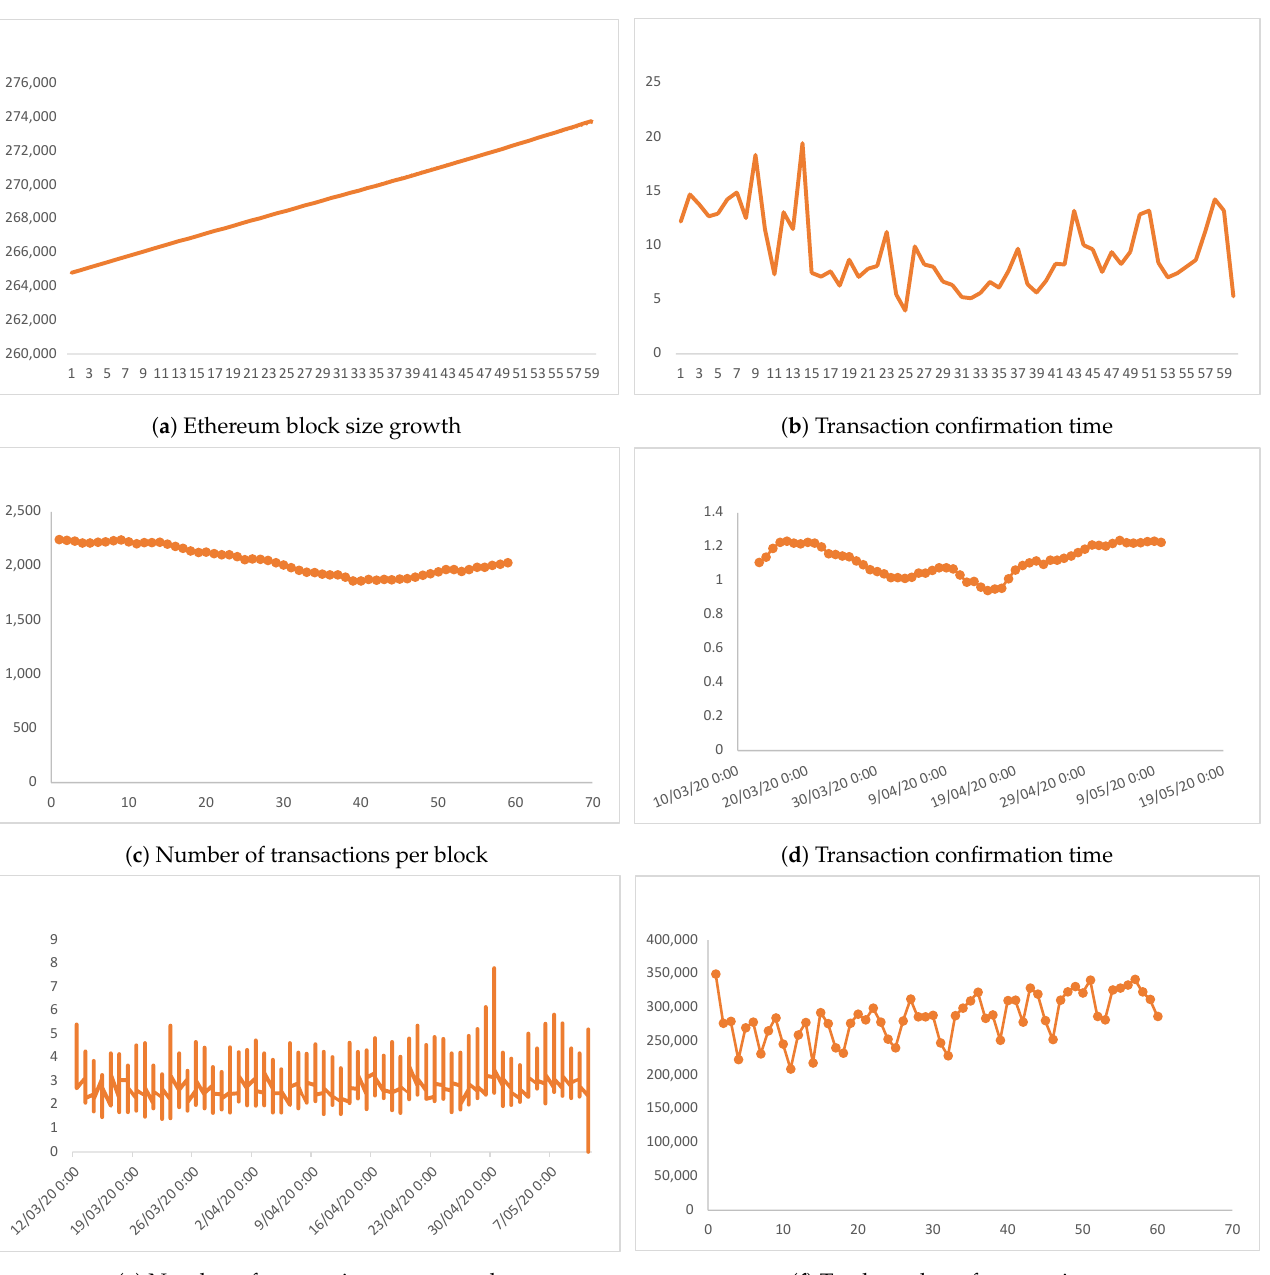
Figure 9. Raw Data of Experiment